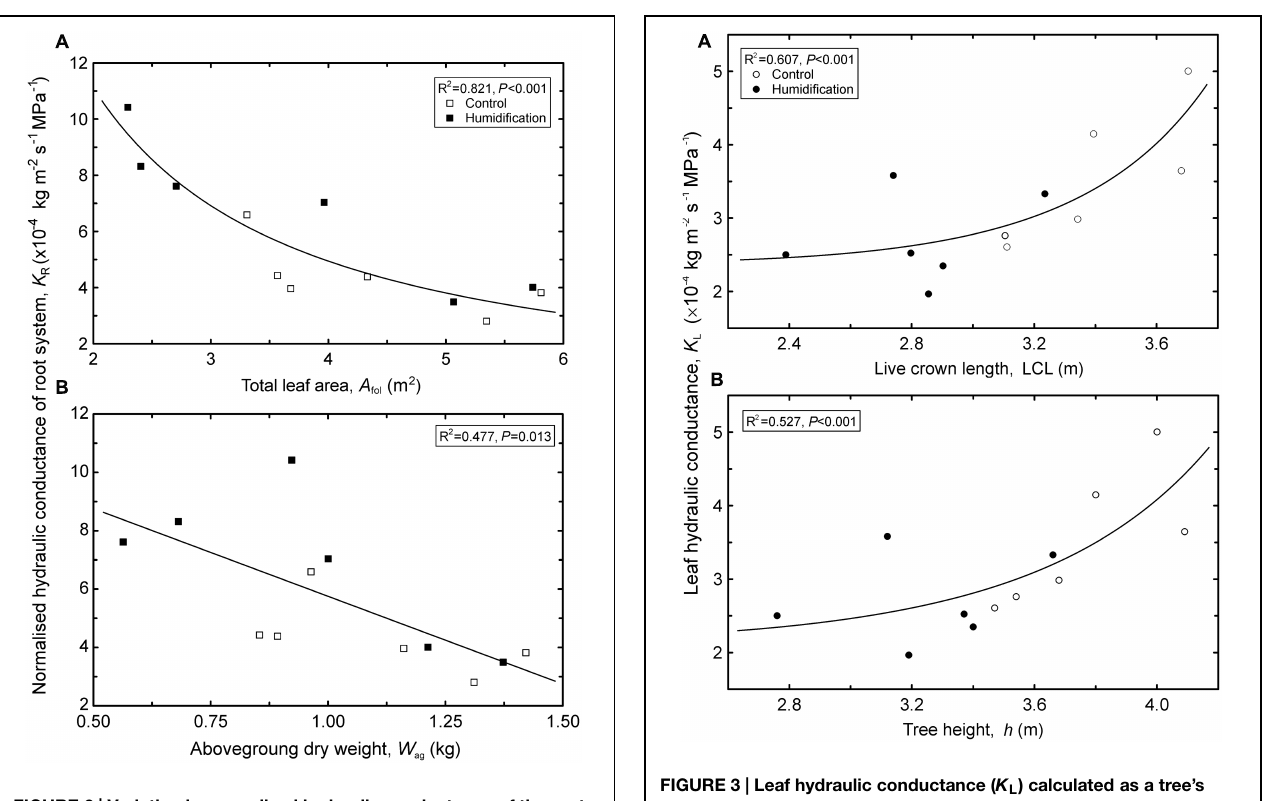
FIGURE 2 | Variation in normalized hydraulic conductance of the root system ( K R ) depending on tree total leaf area ( A fol ; A) and